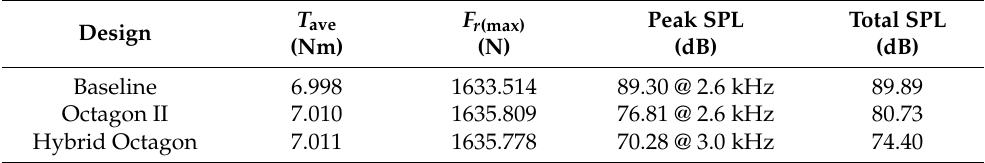
Table 6. Performance comparison for the evaluated stator yoke designs.